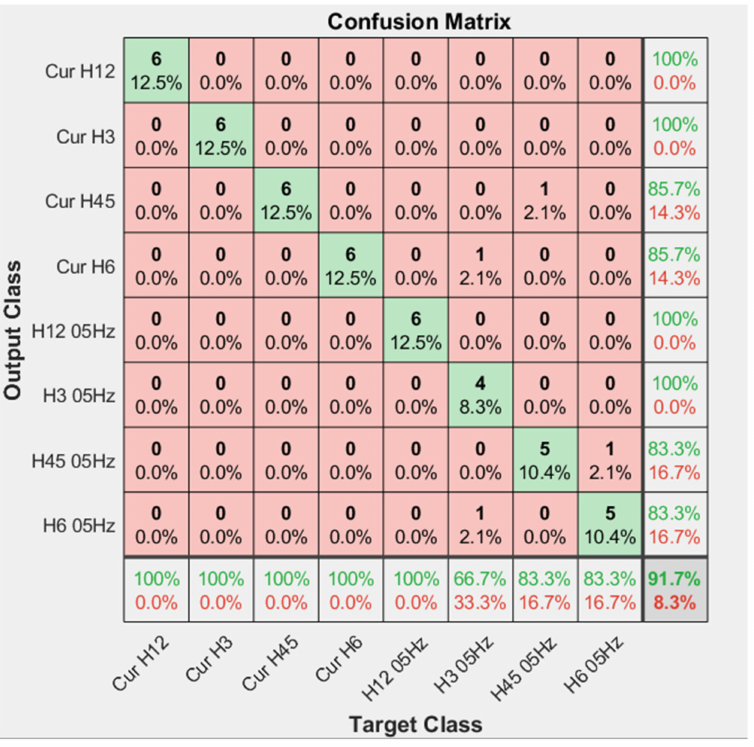
Figure 20. Confusion matrix (test set) for the eight classes setup (with scalogram